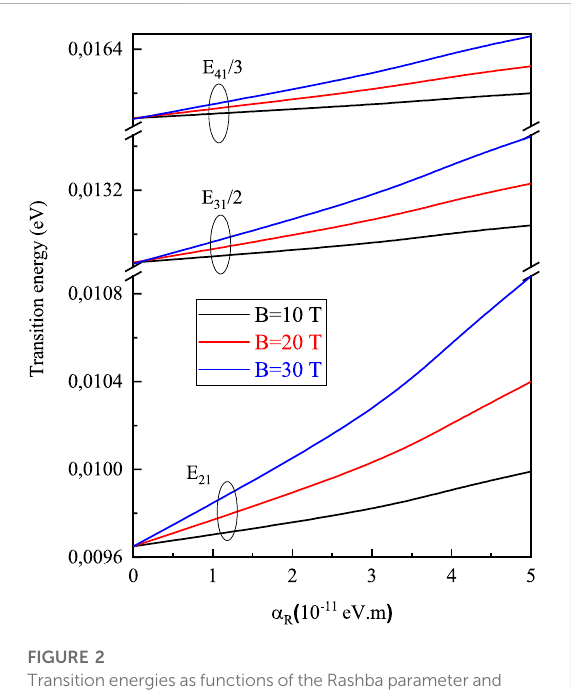
FIGURE 2 Transition energies as functions of the Rashba parameter and